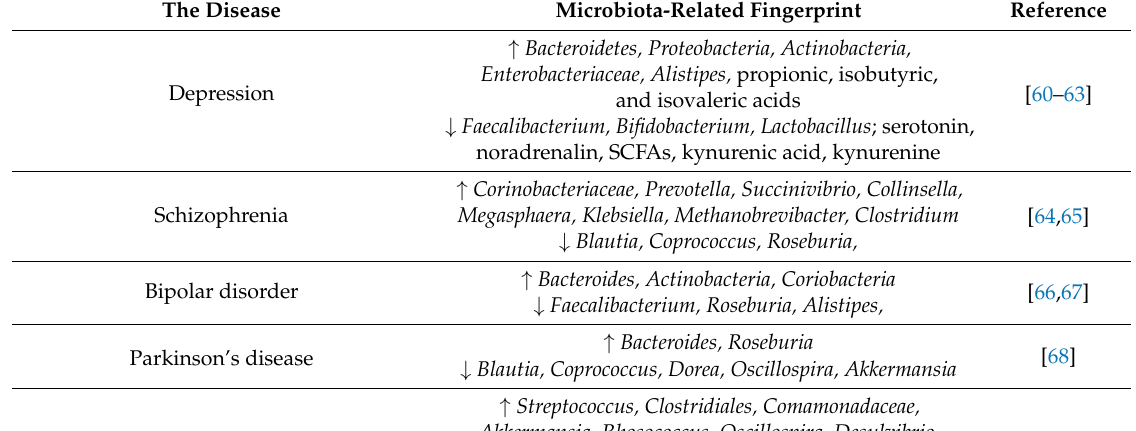
Table 1. Microbiota and its metabolites alterations in various psychiatric